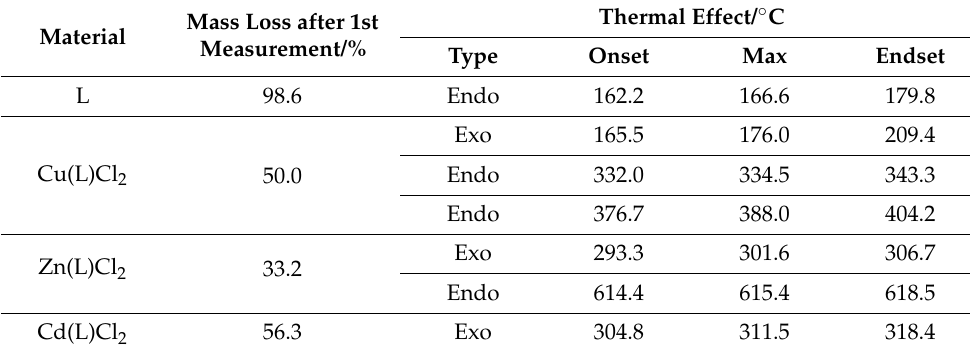
Table 2. Mass loss and thermal effects in investigated samples.